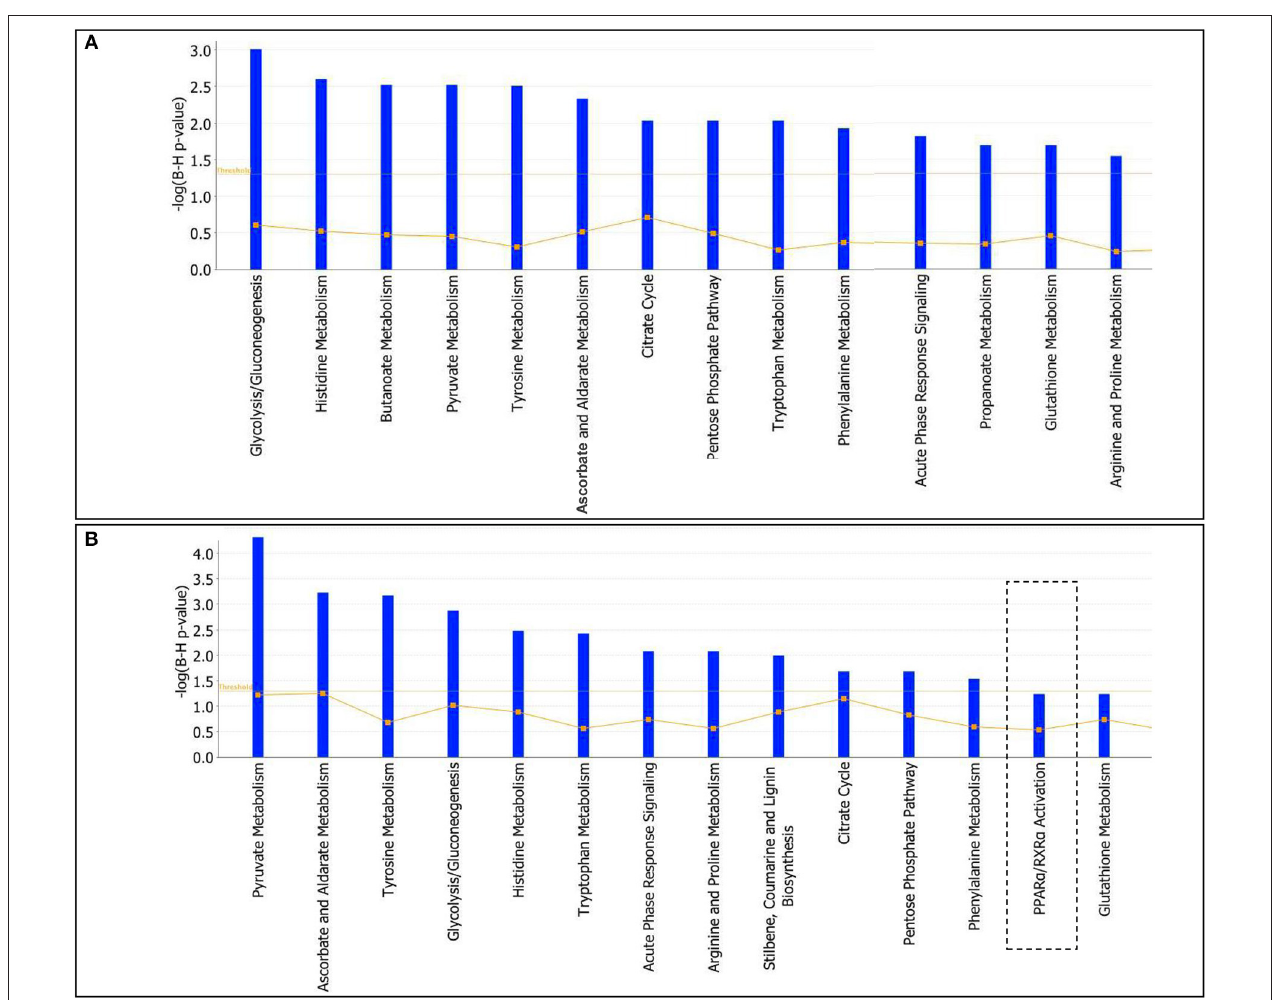
FIGURE 6 | T3 and T2 affected canonical pathways in liver of Ldlr − / − mice: in silico analysis. The lists of differentially expressed proteins were input into the IPA platform (Ingenuity ® Systems, http://www.ingenuity.com) for functional enrichment analysis. Over-represented canonical pathways for Ldlr − / − + T2 (A) and Ldlr − / − + T3 (B) vs. Ldlr − / − deregulated proteins are represented in barplots by their statistical score (negative logarithm to the base 10 of B-H corrected p -value) with a threshold of 1.3 (yellow straight line). The ratio between deregulated and all proteins of a pathway is also reported (yellow not straight